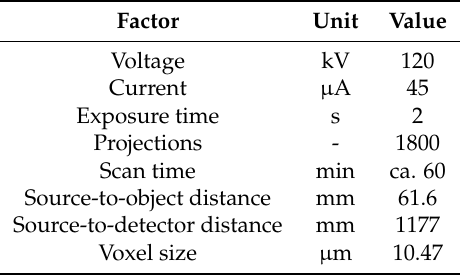
Figure 2. Schematic representation of the CT scanning procedure. Table 4. CT scanning